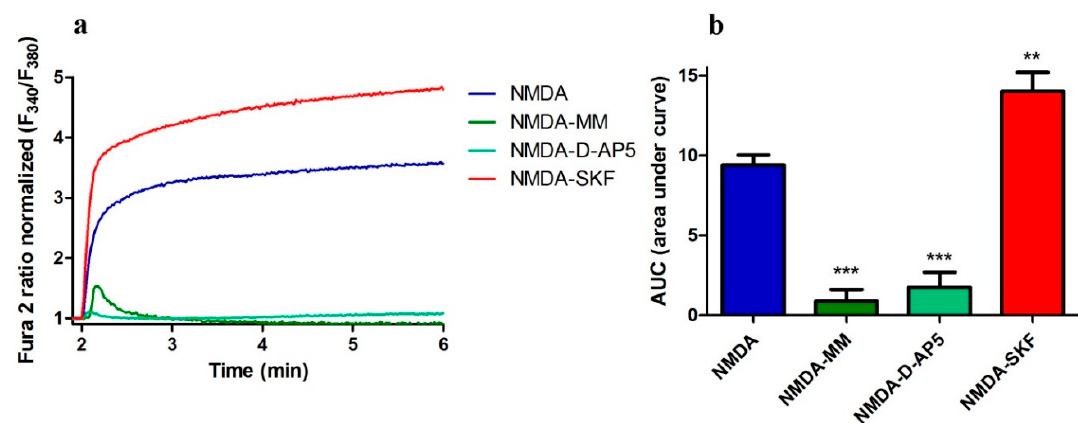
Figure 2. SKF96365 increases NMDA-induced Ca 2+ levels. ( a ) Analysis of the [Ca 2+ ] i induced by NMDA (100 µM) and glycine (10 µM) in the presence of 5 µM nimodipine, 30 µM CNQX, and 50 µM MM; 50 µM D-AP5 or 30 µM SKF96365 (SKF) based on ratiometric measurements with Fura2-AM. F 340 /F 380 values just before adding the NMDAR agonist were normalized to the same values (1). The data represent n independent experiments that were conducted on four different primary cultures corresponding to 516 (NMDA, n = 13), 305 (NMDA-MM, n = 10), 245 (NMDA-DAP, n = 10) and 624 (NMDA-SKF, n = 19) analyzed cells. ( b ) Summary of data from ( a ) shown as area under the curve (AUC), which was calculated from the moment immediately before the addition of NMDA. ** p < 0.01; *** p < 0.001 significantly di ff erent compared with NMDA (ANOVA followed by Tukey’s Multiple Comparison